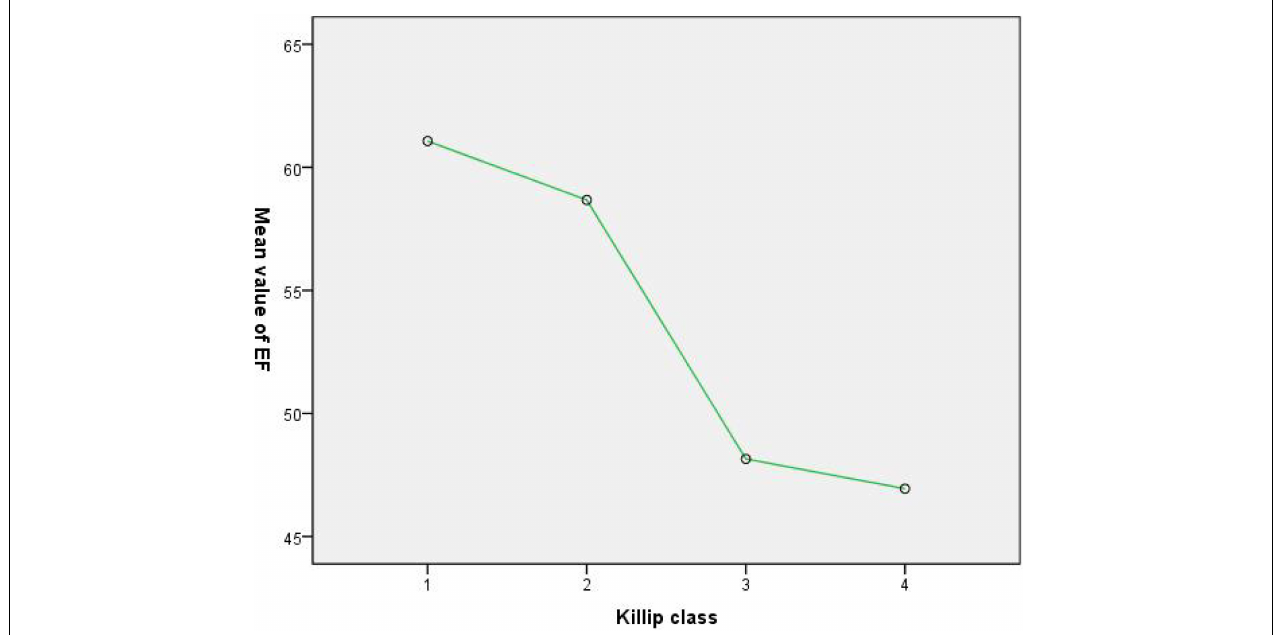
FIGURE 1 | Higher Killip classes had lower echocardiographic ejection